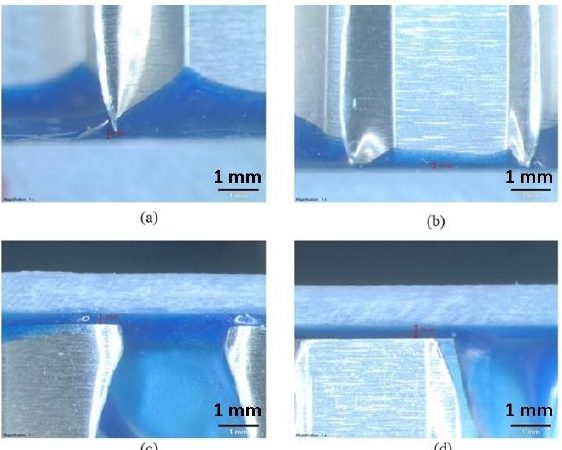
Figure 6. Low-density honeycomb (LDHC) face sheet/core interface: ( a ) and ( b ) show the top face sheet/core interface at two different locations; ( c ) and ( d ) show the bottom face sheet/core interface at two different locations.